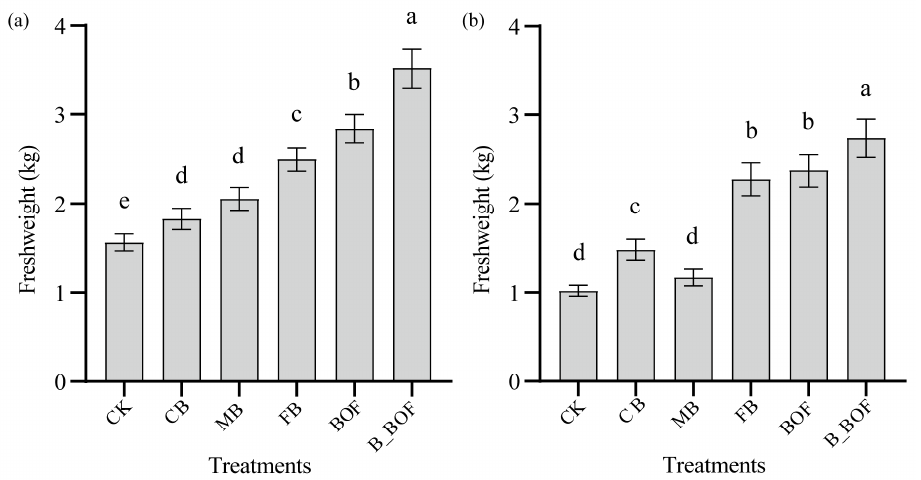
Figure 1. Effect of biochar and BOF on M. crystallinum and A. cordifolia fresh biomass. CK: soil without amendment; CB: soil amended with 10 mesh biochar; MB: soil amended with 30 mesh biochar; FB: soil amended with 60 mesh biochar; BOF: soil amended with BOF; B_BOF: soil with 60 mesh biochar and BOF. Error bars represent standard errors of the means (n = 3). Different lowercase letters indicate significant difference among treatments ( p < 0.05). ( a ) M. crystallinum , ( b ) A. cordifolia .